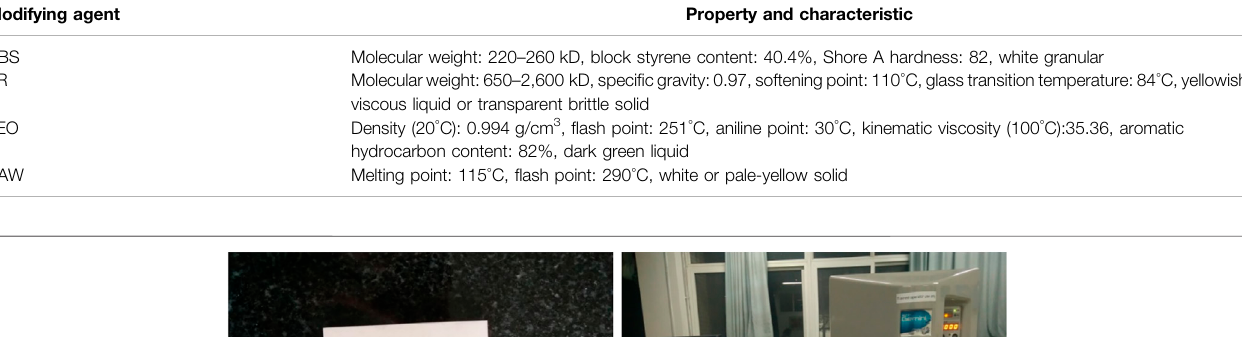
TABLE 2 | Properties of modifying agents.